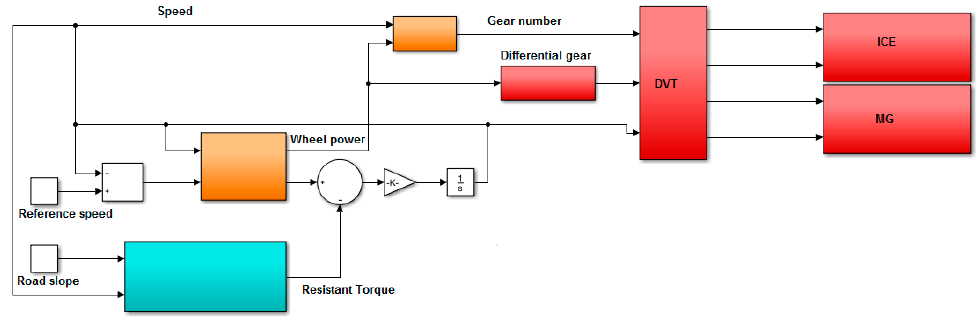
Figure 11. DVT MATLAB/Simulink model.